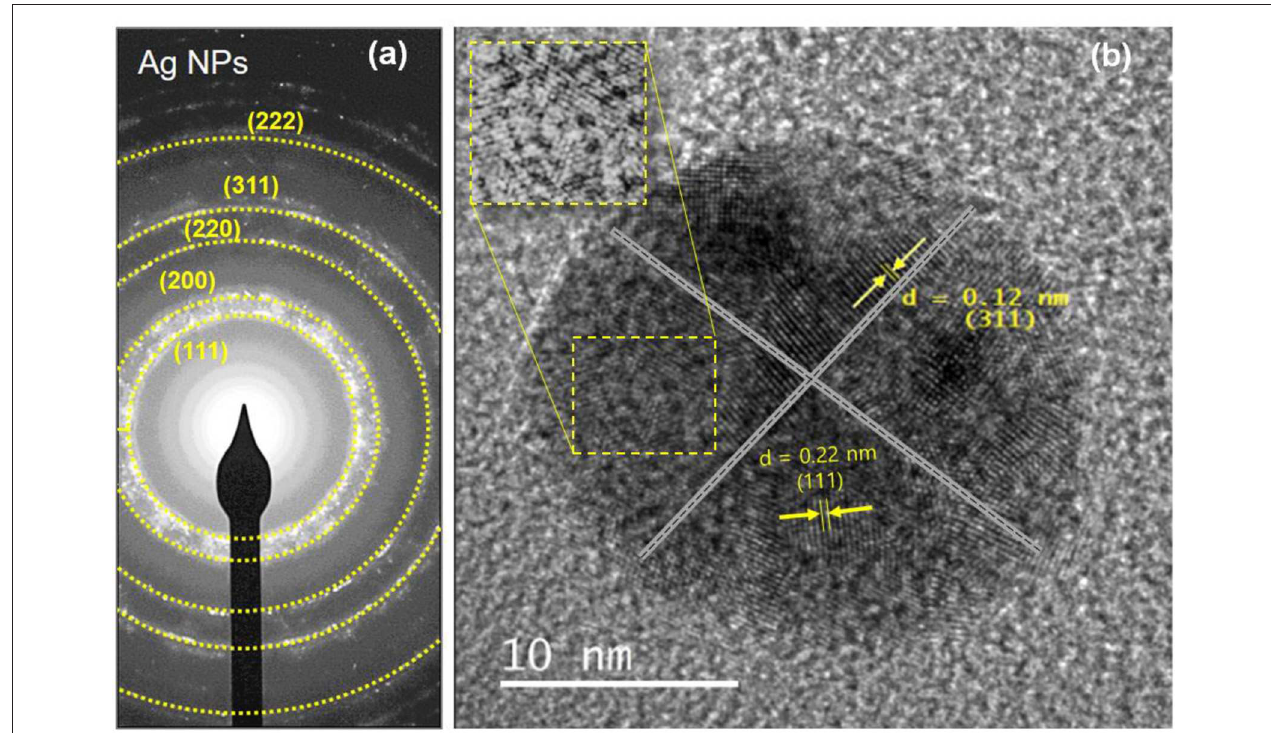
FIGURE 5 | The SAED pattern of (a) E. spiralis /Ag-NPs and (b) the lattice spacing of E. spiralis /Ag-NPs.